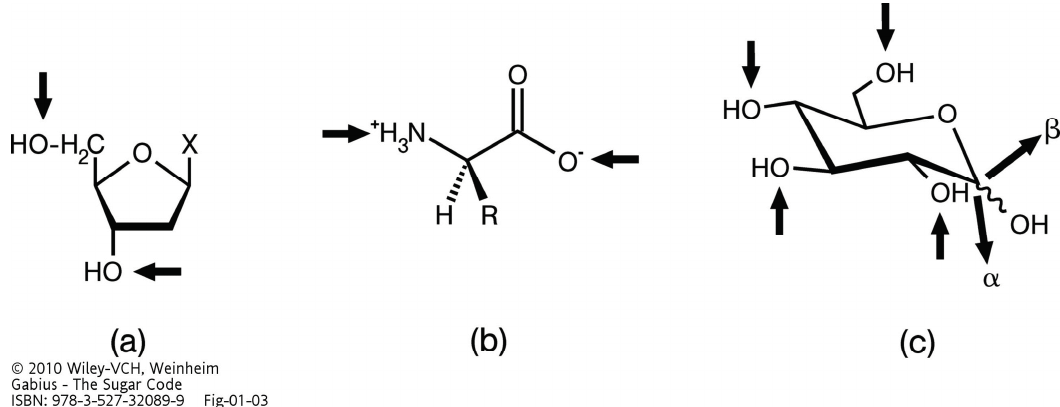
Figure 1. Illustration of the linkage points for oligomer formation in biomolecules by arrows. The phosphodiester bond in nucleic acid biosynthesis ( a ) and the peptide bond in protein production ( b ) yield linear oligomers. For each reaction, the same types of functional groups are involved throughout polymerization. In contrast, the glycosidic linkage in oligosaccharides can involve any hydroxyl group, opening the way to linear and also branched structures ( c ). Using D -glucose as an example, its active form UDP-Glc enables conjugation of this sugar to carbohydrate acceptors to any hydroxyl group of carbohydrate acceptors, as symbolized by arrows directed towards the hydroxyl groups. The anomeric position in chain elongation can be α or β , as symbolized by two bold arrows pointing away from the molecule (from [1], with